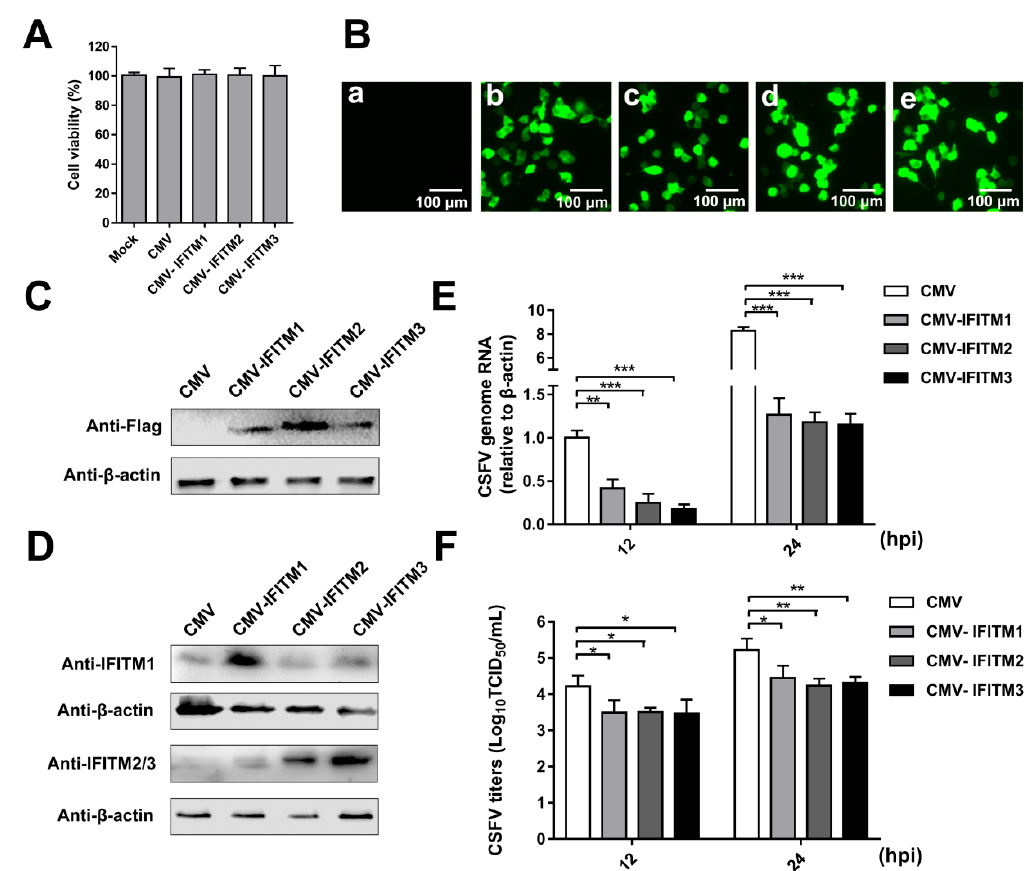
Figure 1. Overexpression of IFITMs inhibits classical swine fever virus (CSFV) replication in porcine alveolar macrophages (PAMs). ( A ) Cell viability of cell lines stably overexpressing IFITMs. ( B ) Confirmation of CMV-IFITM1, CMV-IFITM2, and CMV-IFITM3 lentivirus transfection by detection of enhanced green fluorescent protein (EGFP) reporter. ( a ) Mock-transfected PAMs. ( b ) PAMs transfected with lentiviruses expressing CMV. ( c ) PAMs transfected with CMV-IFITM1 lentivirus, CMV-IFITM2 lentivirus ( d ), and CMV-IFITM3 lentivirus ( e ). Scale bars, 100 µ m. ( C ) Western blot analysis of PAM cell lines stably expressing Flag-tagged IFITM1, IFITM2, or IFITM3 or CMV alone using an anti-Flag antibody. ( D ) Western blot analysis of IFITMs in PAM cell lines stably expressing Flag-tagged IFITM1, IFITM2, or IFITM3 or CMV alone using an IFITM1-specific antibody and an IFITM2/3 antibody against IFITM2 and IFITM3, respectively. β -actin served as an internal control. ( E ) CSFV genomic RNA in CMV-IFITM1, CMV-IFITM2, and CMV-IFITM3 cell lines. The CMV, CMV-IFITM1, CMV-IFITM2, and CMV-IFITM3 cell lines were infected with CSFV at a multiplicity of infection (MOI) of 1. CSFV genomic RNA levels were determined by real-time quantitative PCR (RT-qPCR) at 12 and 24 h post-infection (hpi). Data were normalized to β -actin expression. ( F ) Infectious progeny viral titers in culture medium from CMV-IFITM1, CMV-IFITM2, and CMV-IFITM3 cells. The viral titers of CSFV in supernatants were quantified by an immunofluorescence assay (IFA) and expressed as tissue culture infective dose (TCID 50 )/mL. Data ( A , E , F ) represent the mean ± SD of three independent experiments and were measured in technical duplicate. Comparisons between groups were performed by Student’s t test. * p < 0.05, ** p < 0.01 and *** p < 0.001.